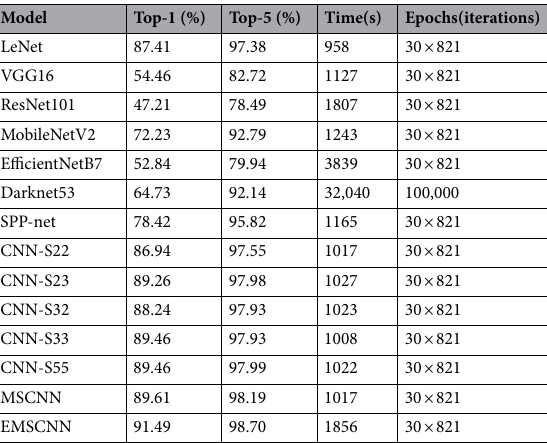
Table 4. Model classification results.